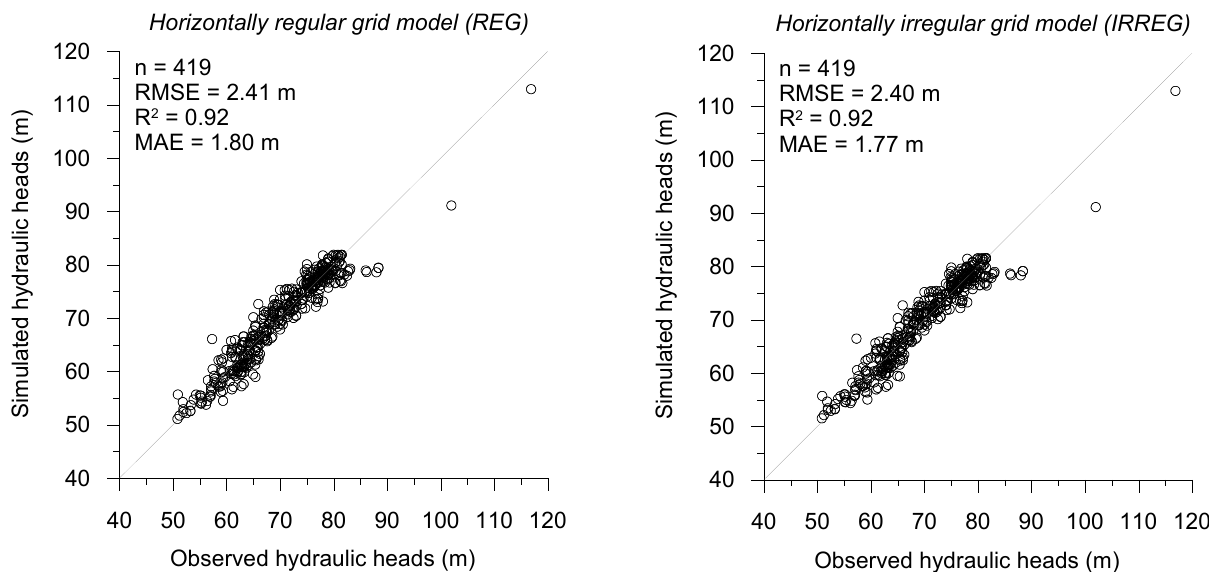
Figure 5. Simulated versus observed hydraulic heads in the two model conceptualizations. The gray line corresponds to the 1:1 line. Table 1. Calibrated parameter values and their associated 95% confidence intervals.